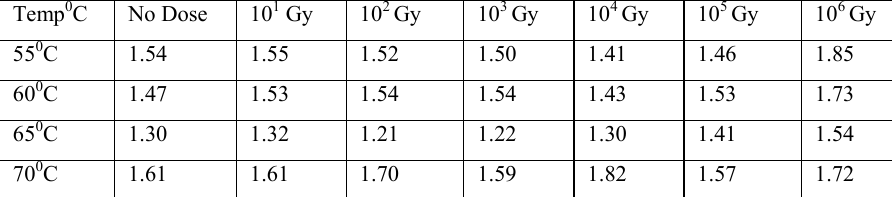
Table 5. Etch-Rate ratio for pre-gamma exposed PADC –American Acrylics.